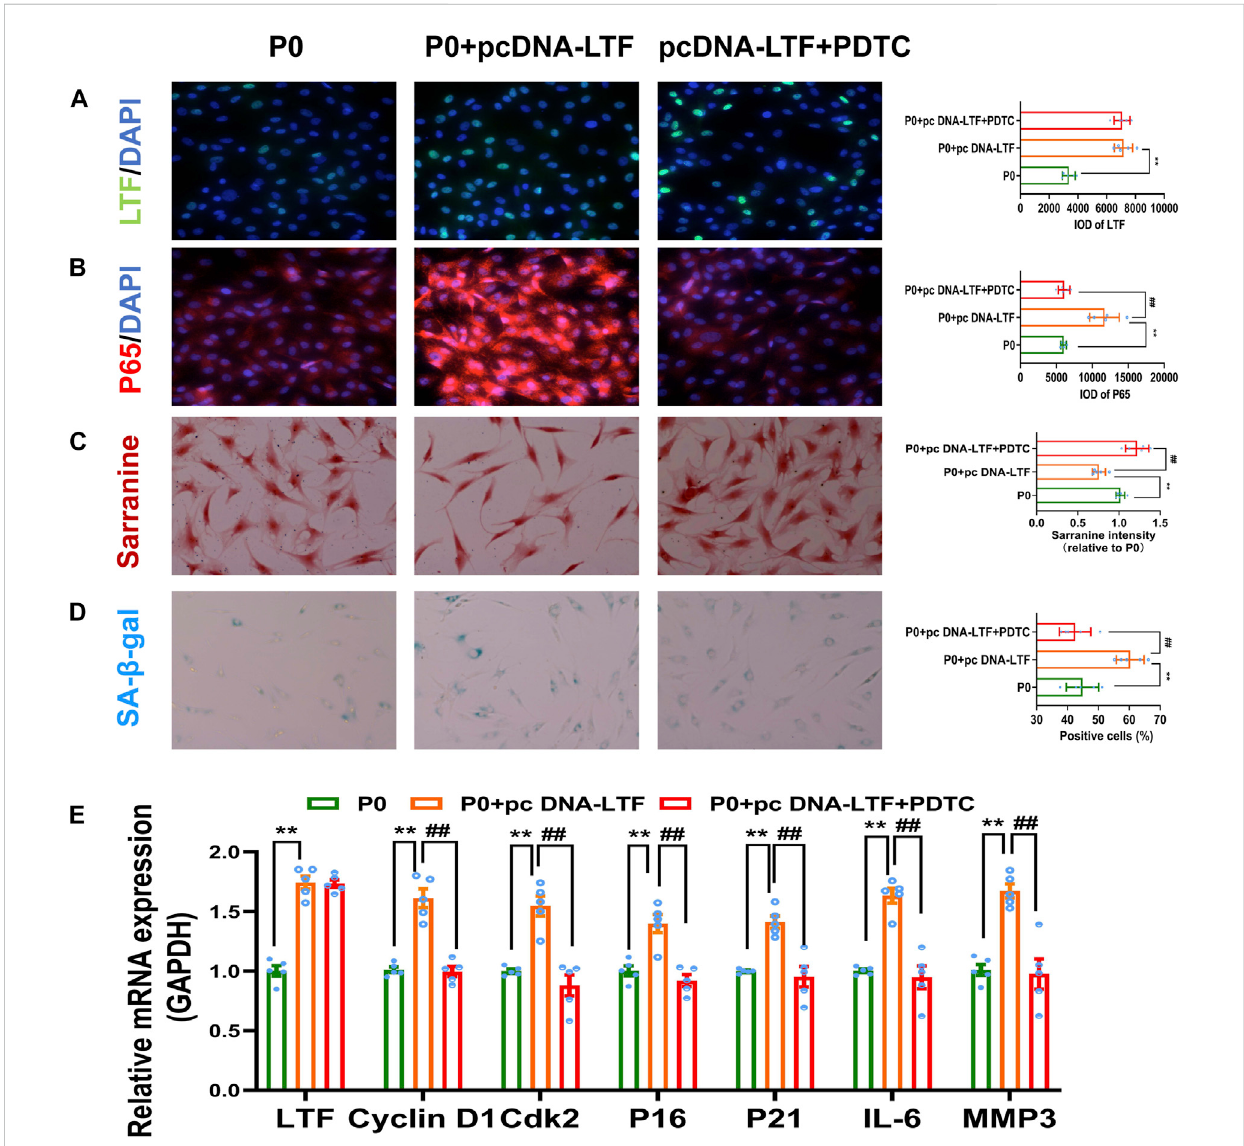
FIGURE 7 Overexpression of LTF contributed to meniscal senescence through the NF- κ B signaling pathway (A, B) Representative images and quantitative analysisofimmuno fl uorescenceforLTFandP65,scalebar=50 μ m (C) RepresentativeimagesandquantitativeanalysisofSafranin-Ostaining,scalebar= 50 μ m (D) Representative images and quanti fi cation of SA- β -Gal positive cells of SA- β -Gal staining, scale bar = 50 μ m (E) The mRNA expression of LTF, Cyclin D1,Cdk2, P16,P21, IL-6 and MMP3. Mean ± S.E.M., * p < 0.05, ** p < 0.01 comparedwith control groups, # p < 0.05, ## p < 0.01, compared with PDTC groups, n = 5. PDTC, pyrrolidine dithiocarbamate; LTF, lactotransferrin; P65, RELA proto-oncogene, NF- κ B subunit; SA- β -Gal, senescence- associated β -galactosidase; Cdk2, cyclin dependent kinase 2; P16 (CDKN2A), cyclin dependent kinase inhibitor 2A; P21 (CDKN1A), cyclin dependent kinase inhibitor 1A; IL-6, interleukin 6; MMP3, matrix metallopeptidase